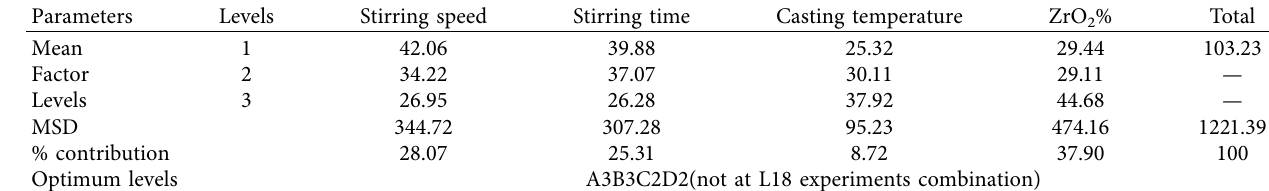
Table 5: Stir-casting progression: pareto ANOVA output results.